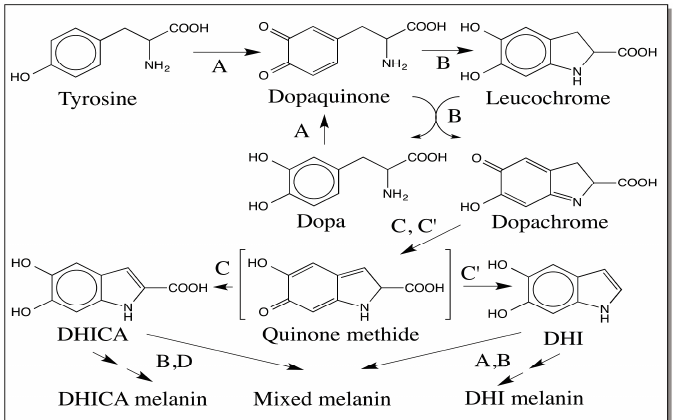
Figure 6. Modified Raper–Mason Pathway for the Biosynthesis of Eumelanin. Tyrosinase (A) catalyzes the oxidation of tyrosine to dopaquinone and conversion of dopa to dopaquinone. Dopaquinone undergoes intermolecular cyclization producing leucochrome, which undergoes double decomposition with dopaquinone generating dopa and dopachrome. Dopachrome is isomerized by DCT to the transient quinone methide intermediate that is converted to DHICA in mammals. Insect DCDT on the other hand produces DHI. Nonenzymatic transformations may also be responsible for DHI versus DHICA production in different systems. Oxidative polymerization of dihydroxyindoles generates different kinds of eumelanin pigments. (B = nonenzymatic reactions; C = mammalian DCT; C ′ = insect DCDT; and D = DHICA oxidase).